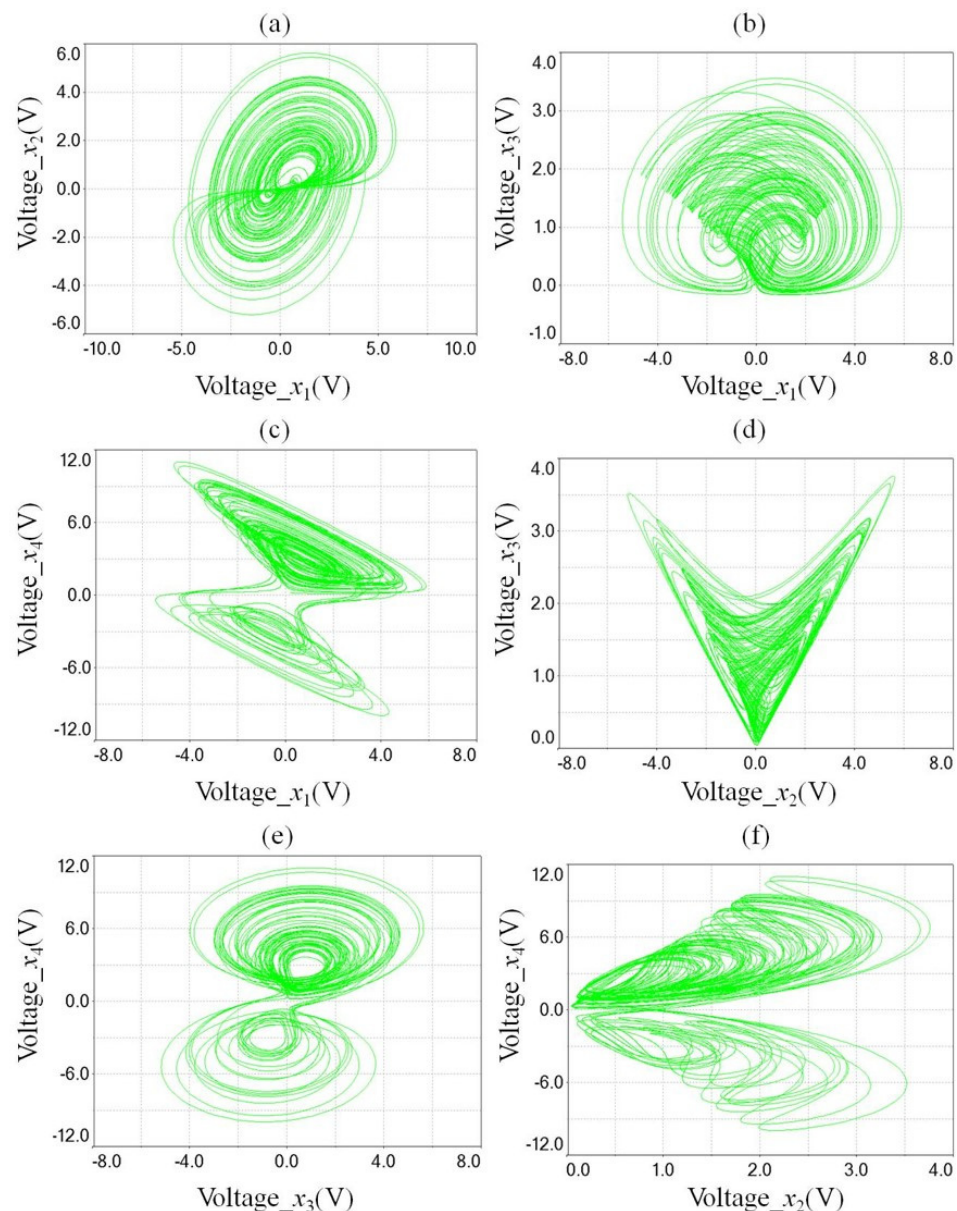
Figure 4. 2 − D phase portraits of the four-dimensional Chen–Lee system simulated by electronic circuits software Multisim: ( a ) 𝑥 (cid:2869) , 𝑥 (cid:2870) plane; ( b ) 𝑥 (cid:2869) , 𝑥 (cid:2871) plane; ( c ) 𝑥 (cid:2869) , 𝑥 (cid:2872) plane; ( d ) 𝑥 (cid:2870) ,𝑥 (cid:2871) plane; circuits software Multisim: ( a ) x 1 , x 2 plane; ( b ) x 1 , x 3 plane; ( c ) x 1 , x 4 plane; ( d ) x 2 , x 3 plane; ( e ) 𝑥 (cid:2870) , 𝑥 (cid:2872) plane; ( f ) 𝑥 (cid:2871) ,𝑥 (cid:2872) plane. ( e ) x 2 , x 4 plane; ( f ) x 3 , x 4